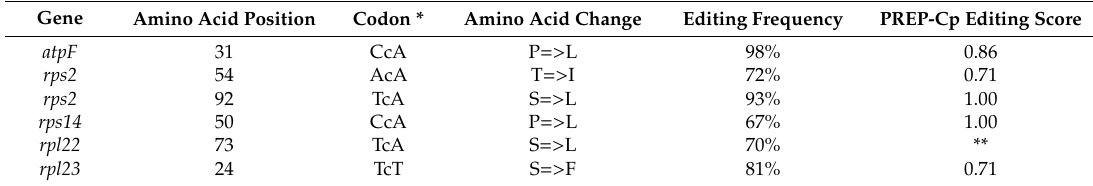
Table 3. RNA-editing pattern in D. rotundifolia plastome identified by RNAseq read alignment.